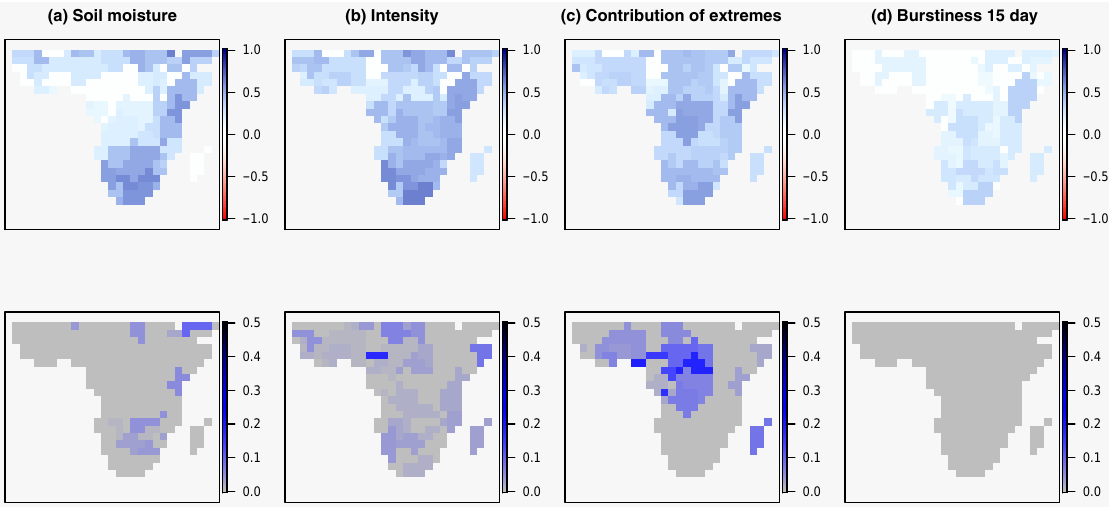
Figure 4. Same as Fig. 2 but for the following variables. (a) Soil moisture: seasonal average moisture in topsoil. (b) Intensity: total rainfall divided by the number of rainy days. (c) Contribution of extremes: total rainfall divided by the amount of rain contributed by the top 95th percentile days. (d) Burstiness 15 day: intermittency measure (Schleiss and Smith, 2016).